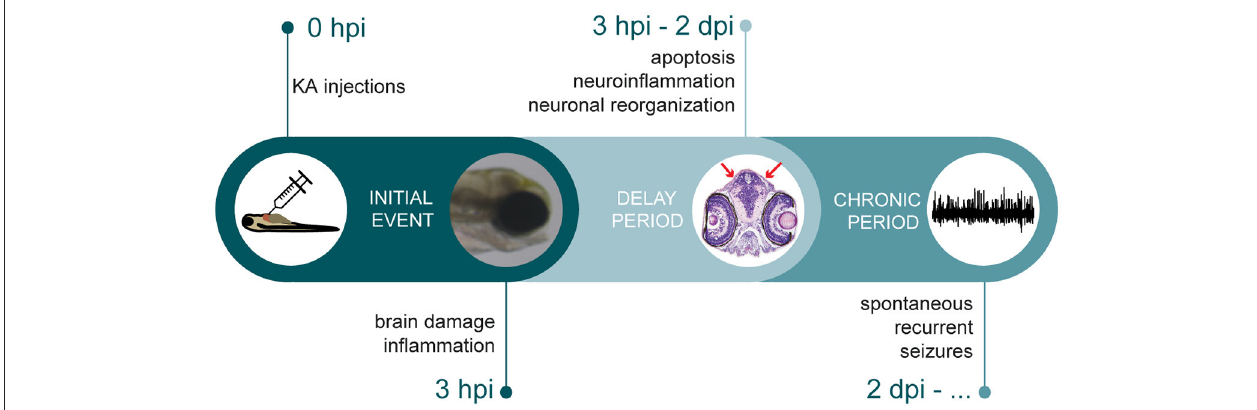
FIGURE 7 | Timeline depicting multiple stages of epileptogenic processes observed in KA larval zebrafish model. After KA injection, immediate brain damage and acute inflammation could be observed at 3 hpi. This was followed by a delay period, where apoptosis, neuroinflammation and neuronal reorganization occurred. Finally, KA-injected larvae displayed spontaneous recurrent brain